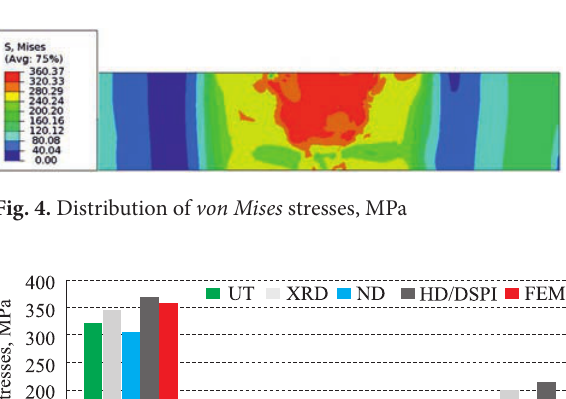
Fig. 3. Distribution of longitudinal residual stresses in specimens